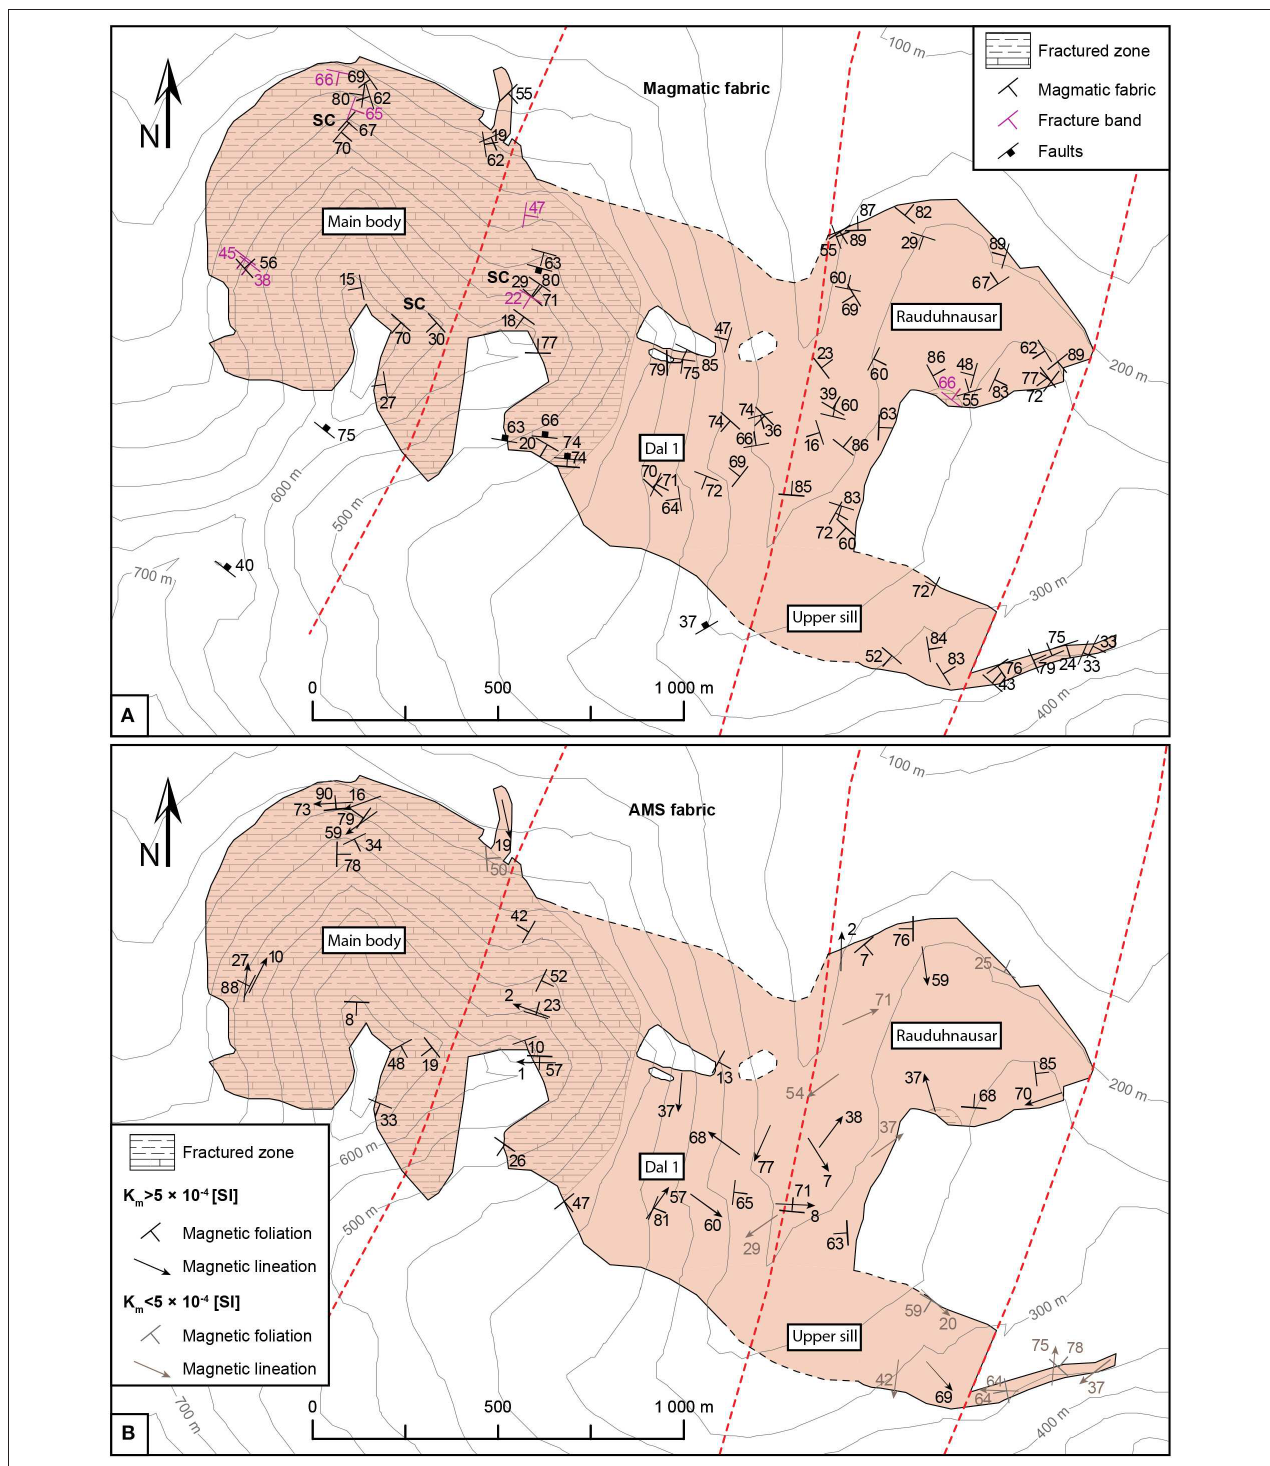
FIGURE 7 | (A) Magmatic flow indicator measurements (mineral alignments, flow bands, platy parting) and fracture bands and larger-scale faults in the Sandfell laccolith. Areas with observed S-C fabric are denoted with the letters “SC” in bold on the map. (B) AMS fabric plotted on map of the Sandfell laccolith. The map includes data from samples with weak magnetic fabric ( K m < 5 × 10 − 4 [SI]). The fracture-banded areas of the laccolith are specified on the map as fractured zone. See Supplementary Video S1 for a 3D interpretation of magma flow.